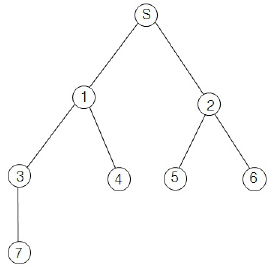
Figure 2. Example of a sensor network.